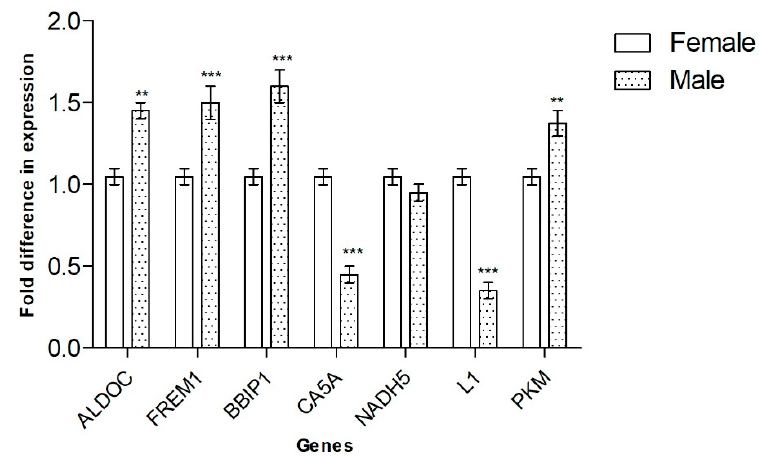
Figure 3. Validation of DDRT-PCR by qRT-PCR. Data are presented as mean with SD. Statistical significance was determined using t-tests with Holm–Sidak correction for multiple comparisons. ** p < 0.01, *** p < 0.001.